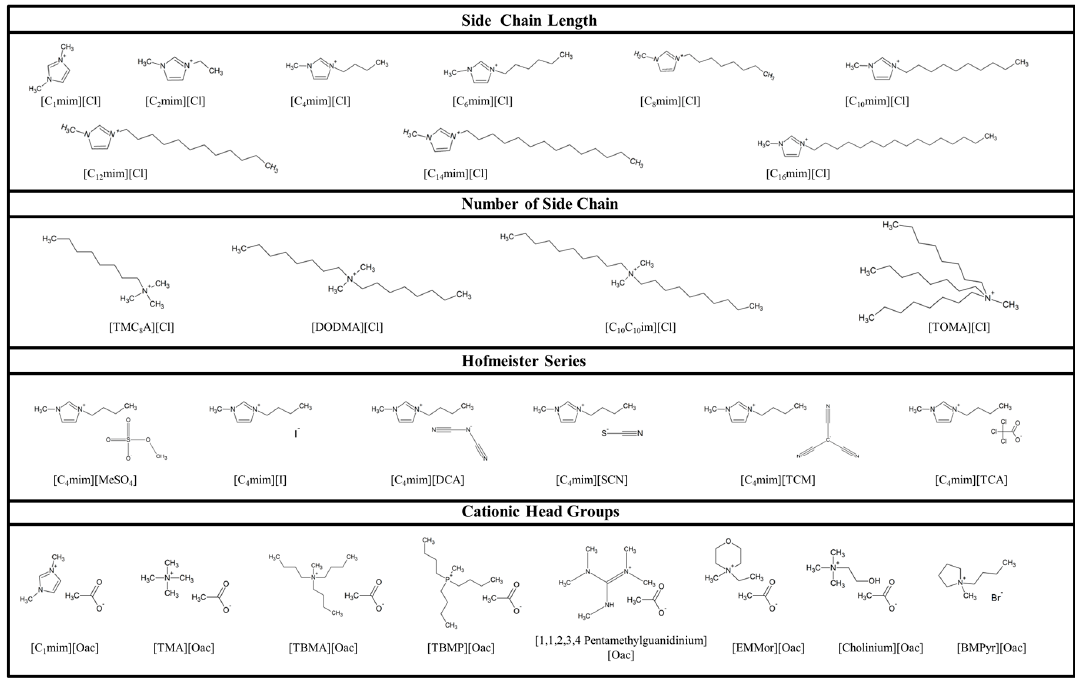
Figure 3. Structure of the 27 tested ILs, arranged according to their investigated structural characteristics.